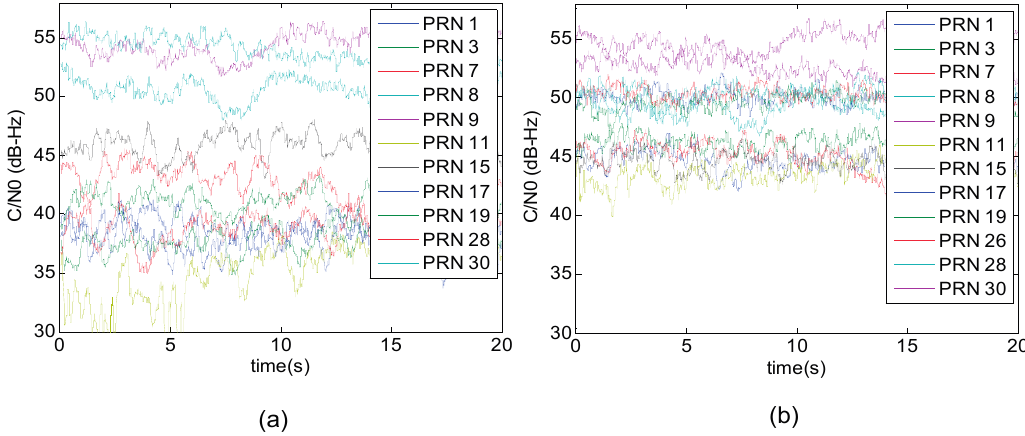
Figure 7. ( a ) Measured C/N 0 after employing the blind STP filtering ( b ) and after employing the proposed distortionless STP